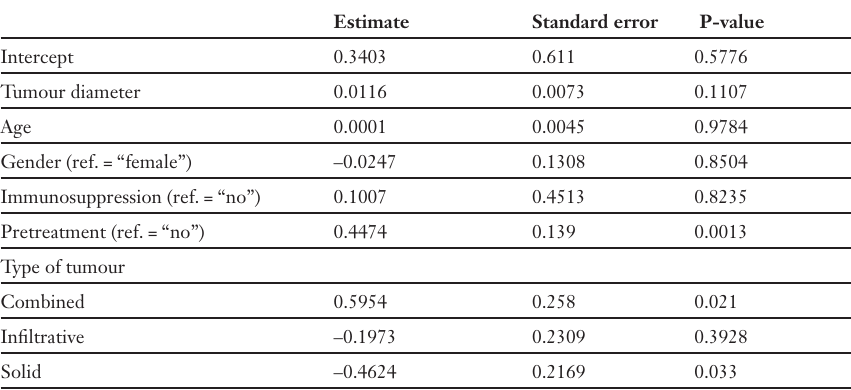
Table 2 Parameter estimates of variables for the number of staged